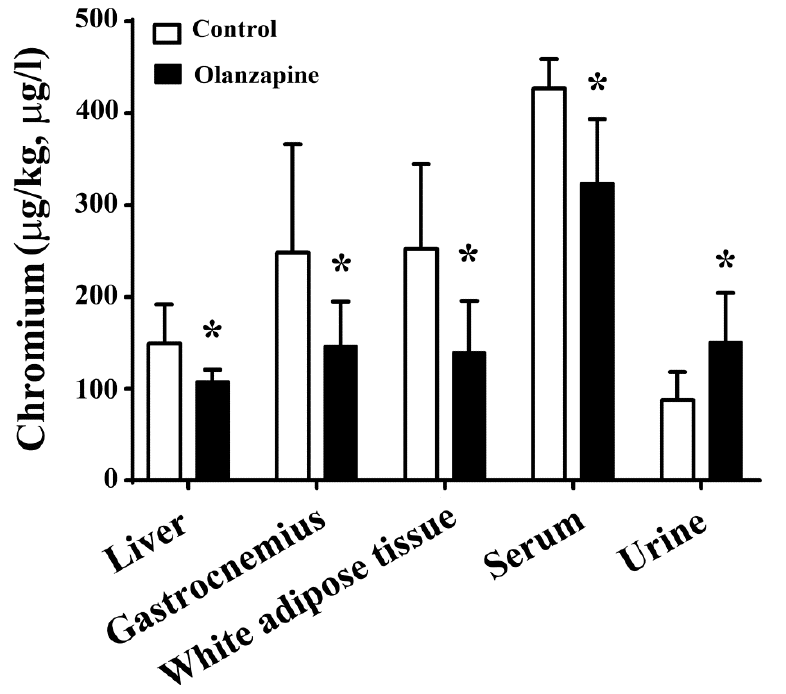
Figure 3. Olanzapine caused tissue chromium mobilization. At the end of the experiments, the excised liver (µg/kg), gastrocnemius (µg/kg), white adipose tissues (including inguinal, periovarian, mesentery, and perirenal fat) (µg/kg), serum (µg/L), and 24-h urine (µg/L) samples were subjected to analyses for the measurement of chromium content. * p < 0.05 vs. control, n = 10.